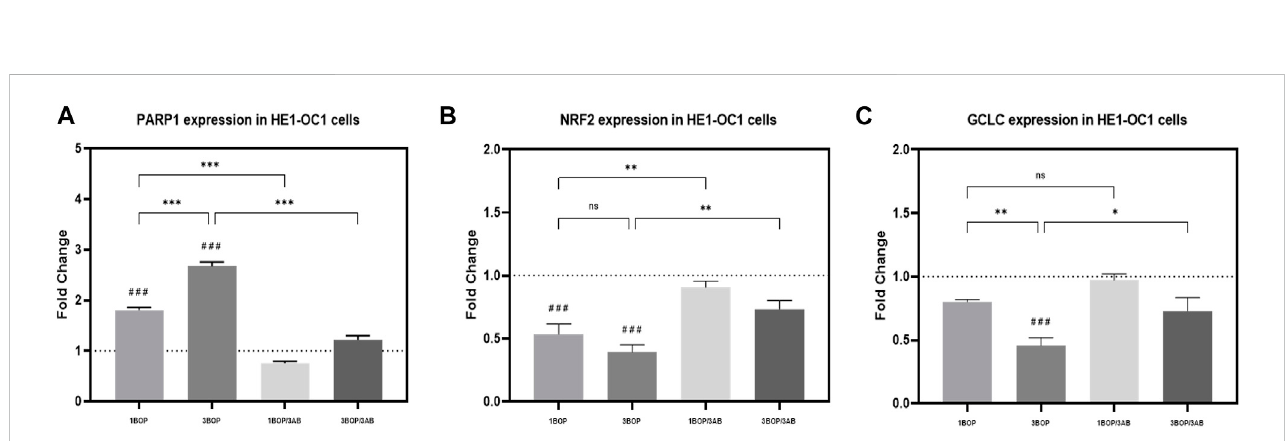
Reverse transcription-quantitative polymerase chain reaction: The histograms represents the mRNA expressions of (A) PARP1, (B) NRF2 & (C) GCLC in HEI-OC1 cells following BOP/3AB treatment (3 mM). * p < 0.05; ** p < 0.005; *** p < 0.001 among groups; ### p < 0.001 versus sham. Values are represented as Mean ± SEM ( n =